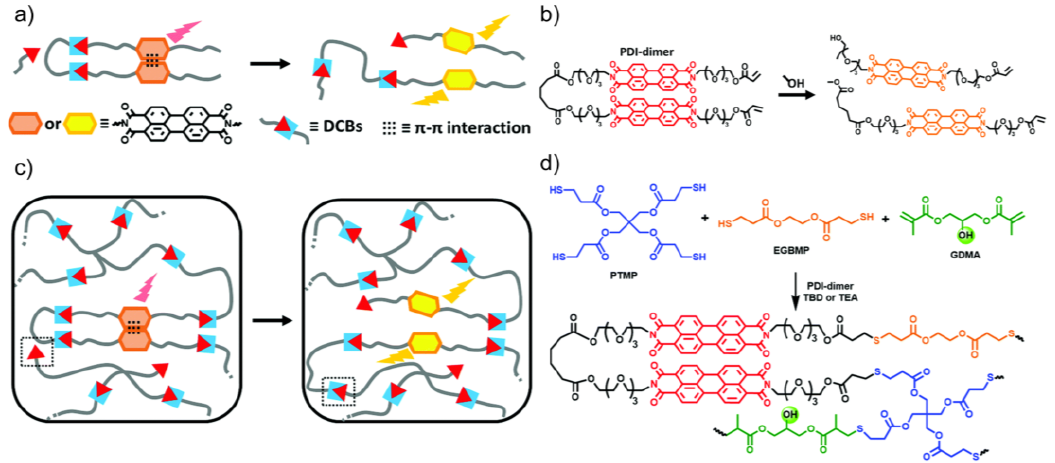
Figure 7. Schematic image of the color change mechanism of the folding fluorescent probe in ( a ) molecule and ( c ) polymer state. ( b , d ) are the molecular structures of the folding fluorescent probe in molecular and polymer state. Reproduced with permission from Ref. [69]. Copyright 2021, Royal Society of Chemistry.